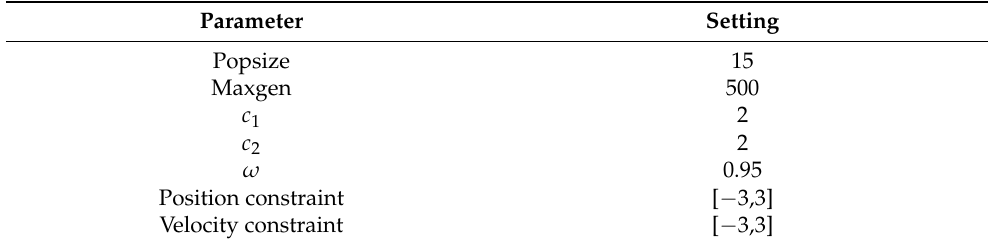
Table 3. Parameter settings for the PS0-ANN